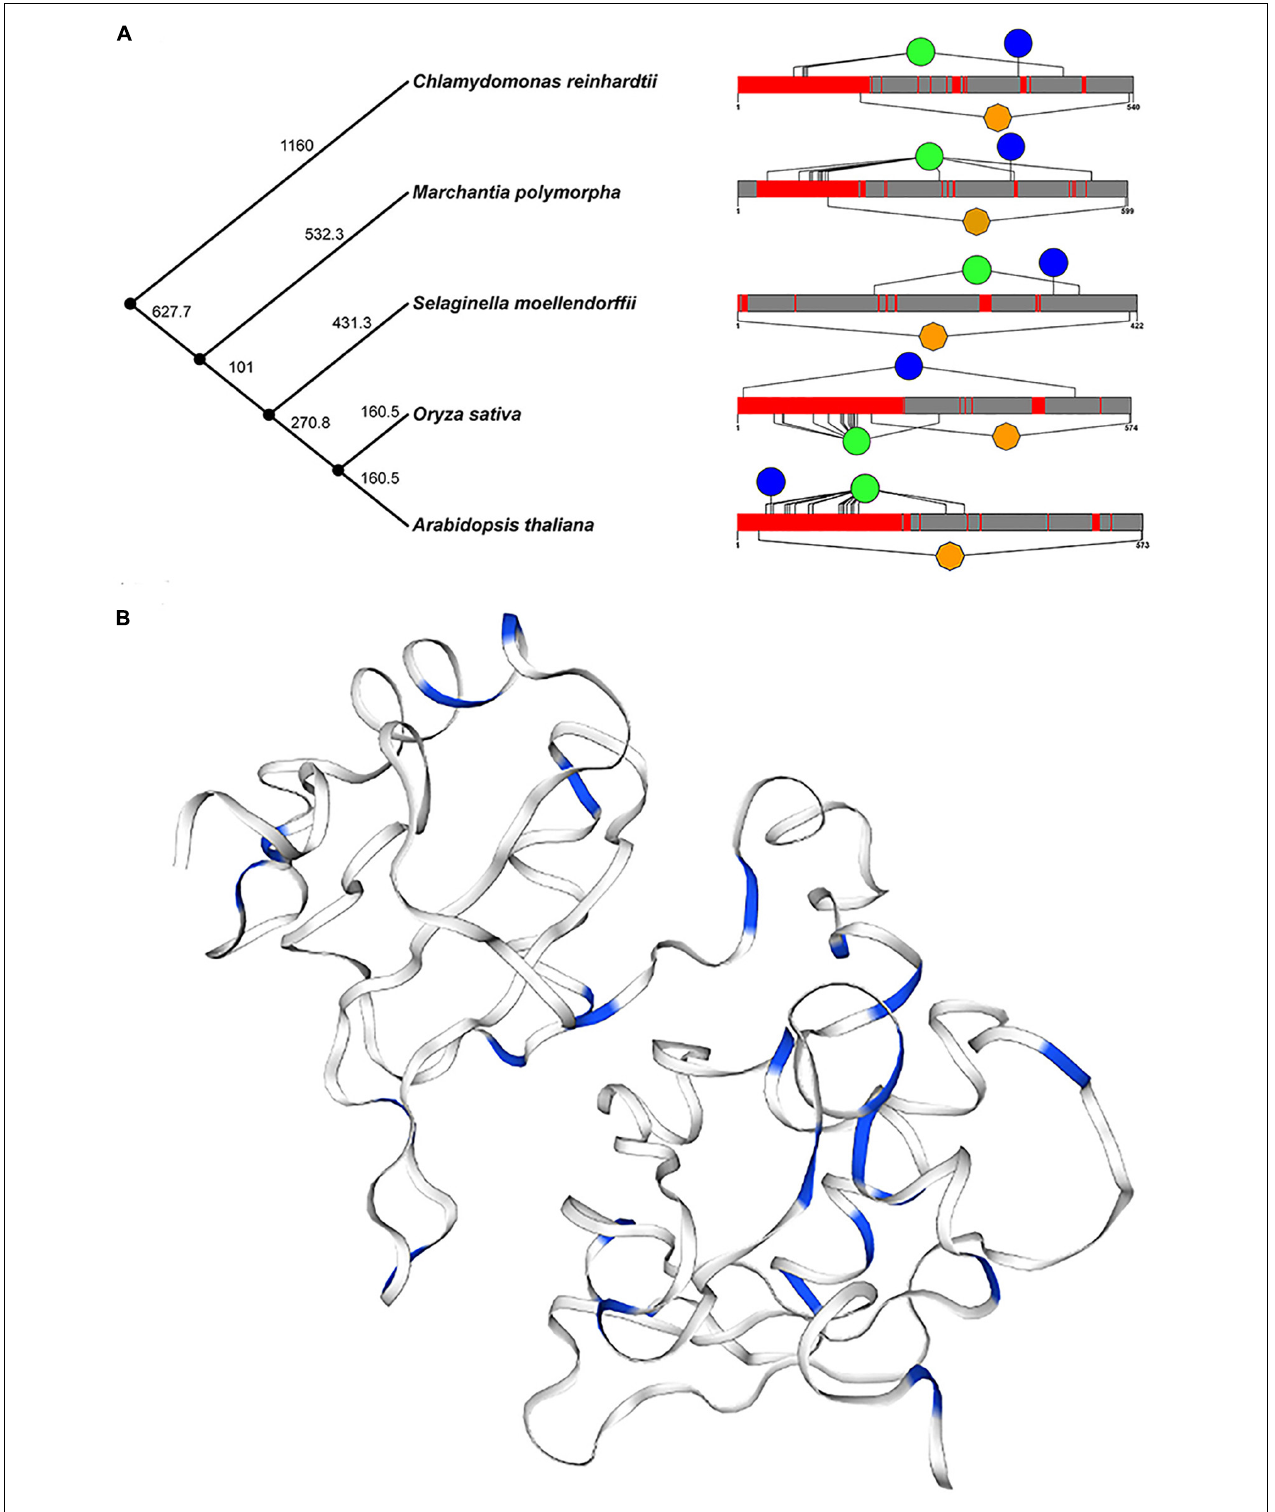
FIGURE 3 | Conservative analysis of plant U2AF65A proteins. (A) Protein structures (right panel) in different plants are shown against time on the phylogenetic tree (left panel) of plants. Orange represents the RRM domain, red represents disorder, blue represents Tyr, and green represents Ser. (B) The three-dimensional structure of plant U2AF65A protein is generated (using Arabidopsis protein sequence) and represented. Blue indicates Ser and Thr in the amino acid sequence.